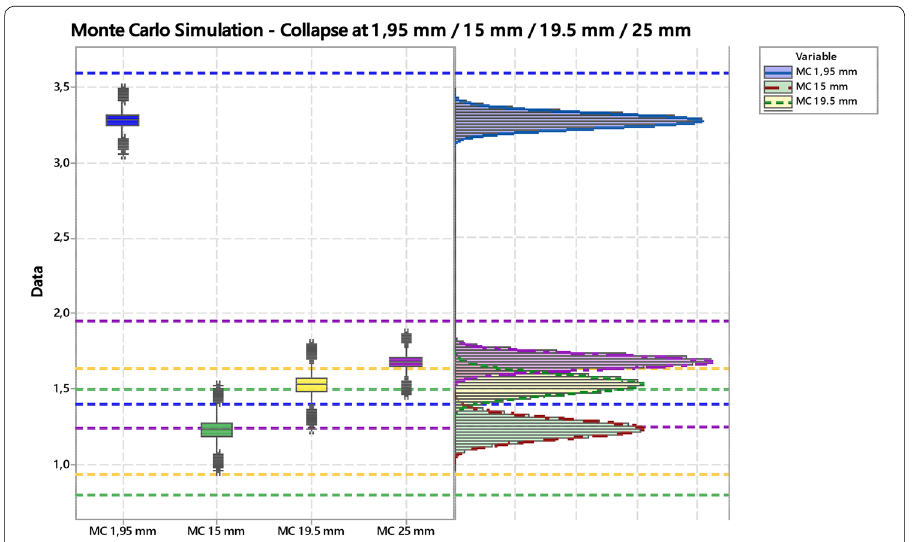
Fig. 20 Probabilistic response calculated for EPS‑CD quasi‑static load